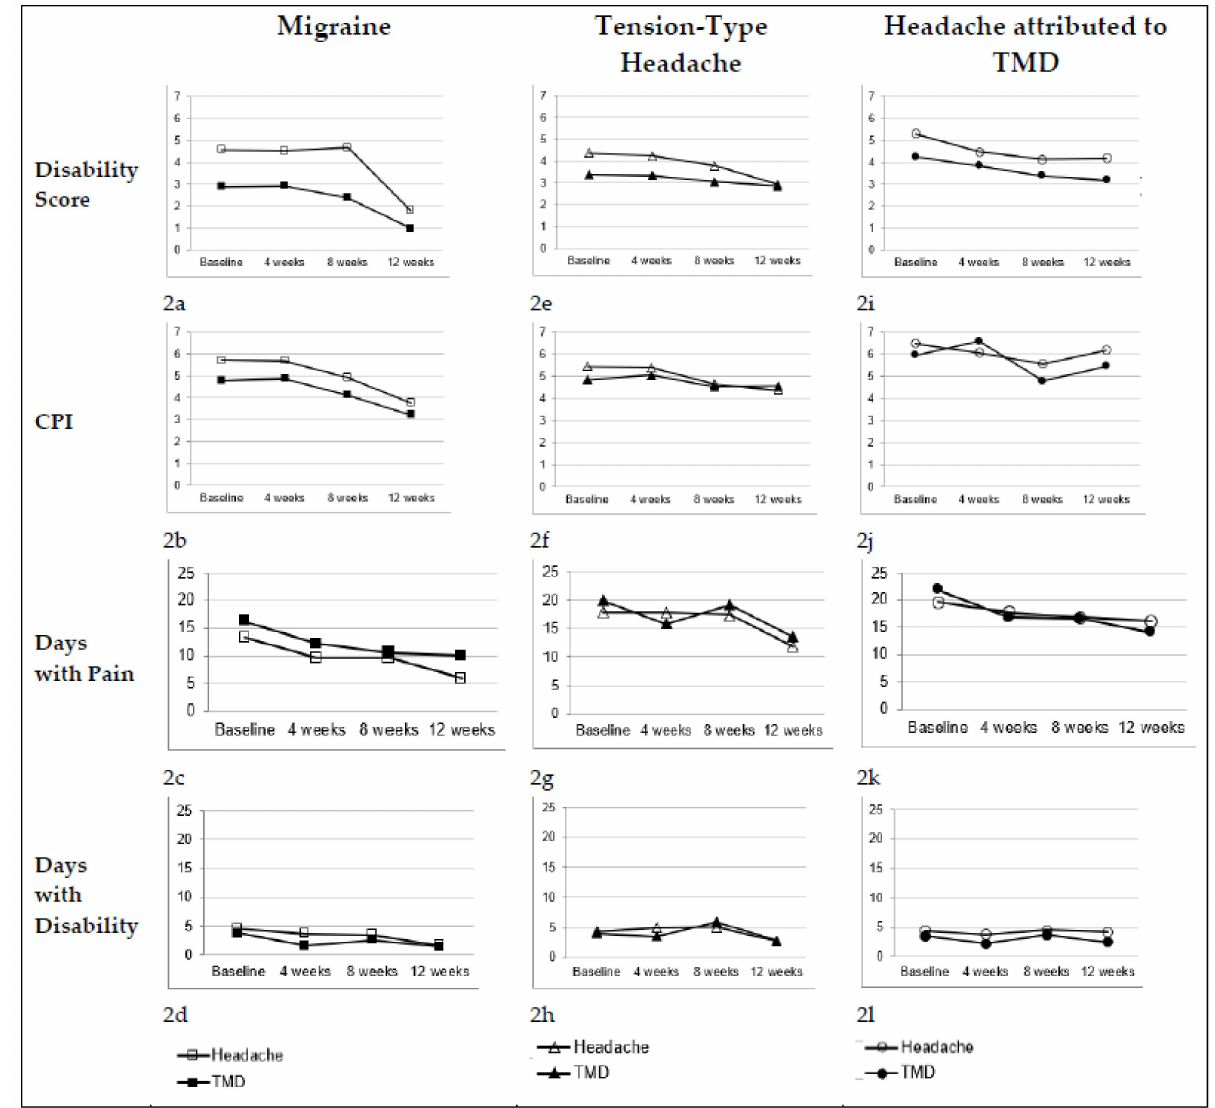
Figure 2. Visual representation of the outcome measures for patients with TMD stratified per headache type (migraine, TTH and headache attributed to TMD): Disability Score ( a , e , i ), Characteristic Pain Intensity ( b , f , j ), Days with Pain ( c , g , k ), and Days with Disability ( d , h , l ). CPI: Characteristic Pain Intensity; TMD: Temporomandibular